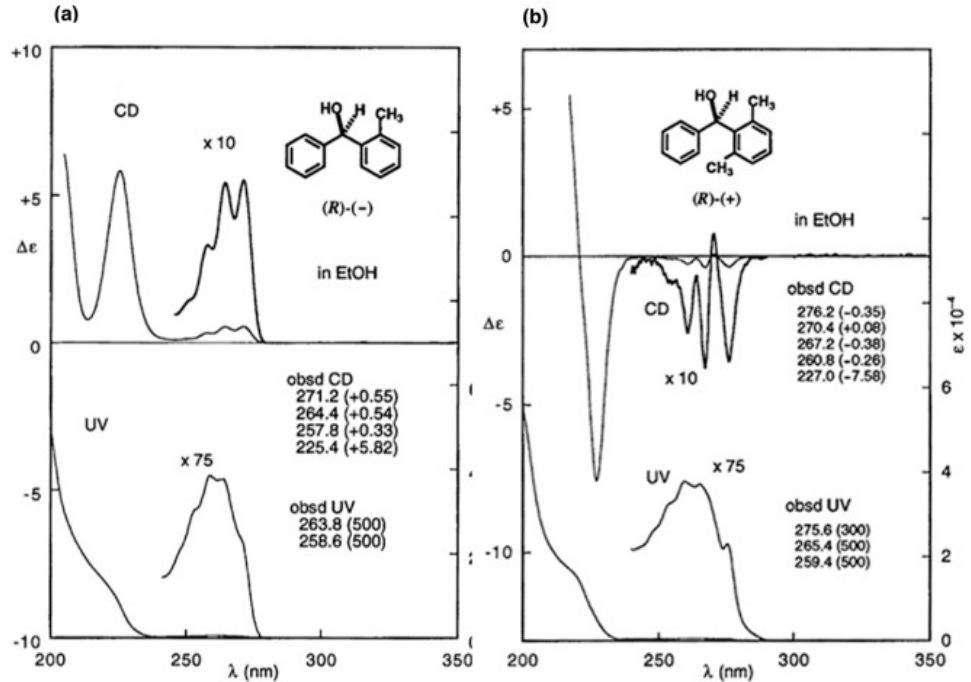
Figure 26. CD and UV spectra of o -substituted diphenylmethanols. ( a ) (2-methylphenyl)phenyl- methanol ( R )-[CD(+)225.4]-( − )- 35 . Reprinted with permission from [41]; ( b ) (2,6-dimethylphenyl)- phenylmethanol ( R )-[CD( − )227.0]-(+)- 37 . Reprinted from [43].